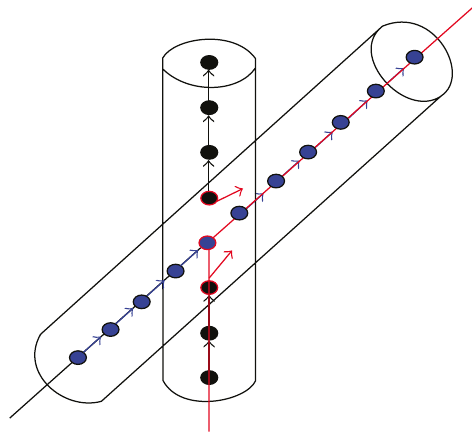
Figure 6: Schematic view of the fiber crossing problem. The currently used minimum eigenvector is pointing into a di ff erent direction than the previous one. This can lead to a wrong segmentation result.